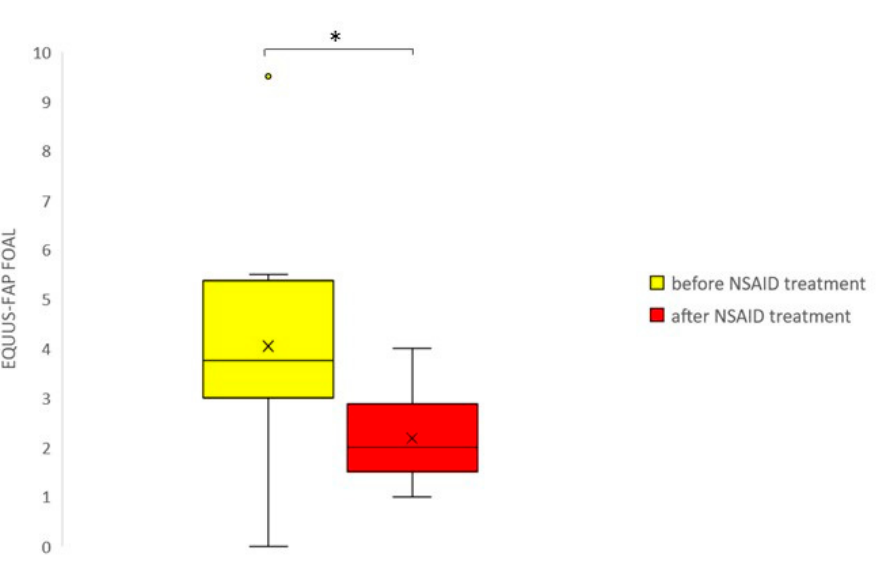
Figure 2. EQUUS-FAP FOAL (Equine Utrecht University Scale for Facial Pain Assessment for foals) in patients, directly before versus 1–2 h after NSAID (Non-Steroidal Anti Inflammatory Drugs) treatment (either Flunixin meglumine or Meloxicam IV). Lines in boxes show median scores; boxes show 25–75th percentiles; error bars show 5–95th percentiles and outliers are shown as dots.*= p < 0.05 ( n = 12).